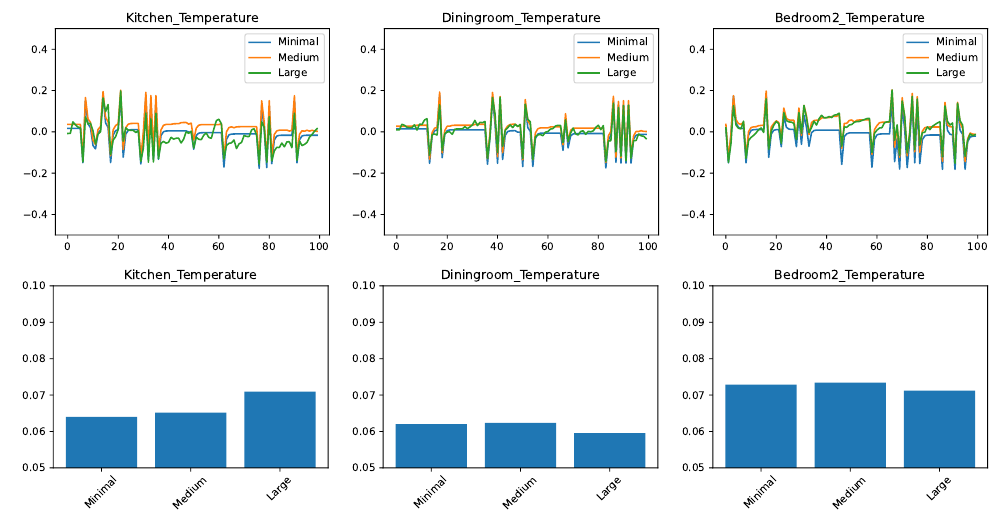
Figure 5. Comparing the prediction of a linear regressor for different feature sets. ( top ) Prediction error in time. ( bottom ) RMSE over the test